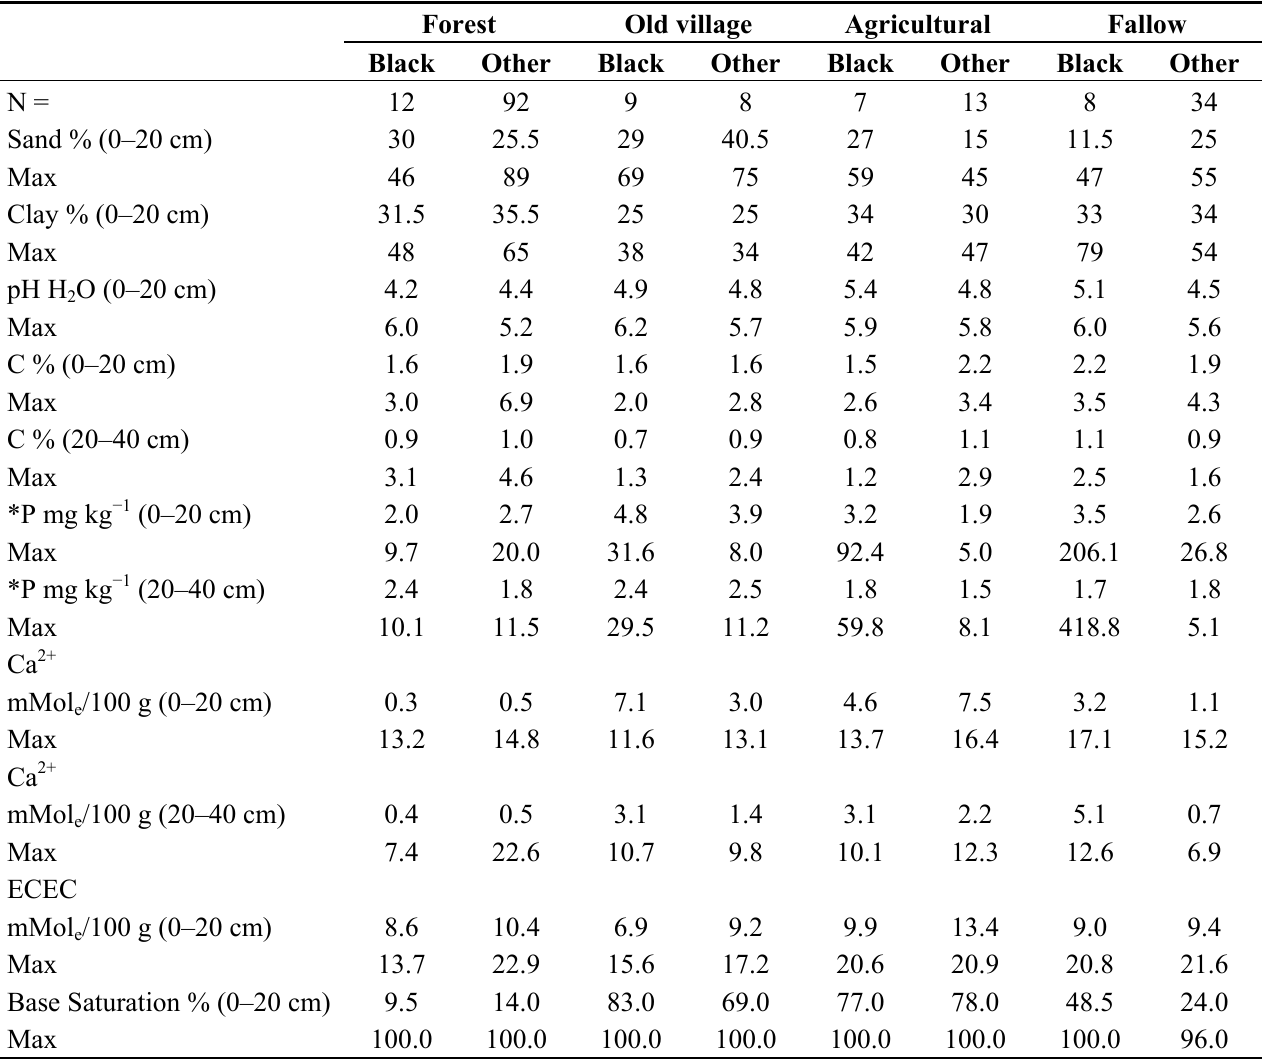
Table 1. Median (and maximum) values for key soil parameters in Malinau. Forest Old village Agricultural Fallow Black Other Black Other Black